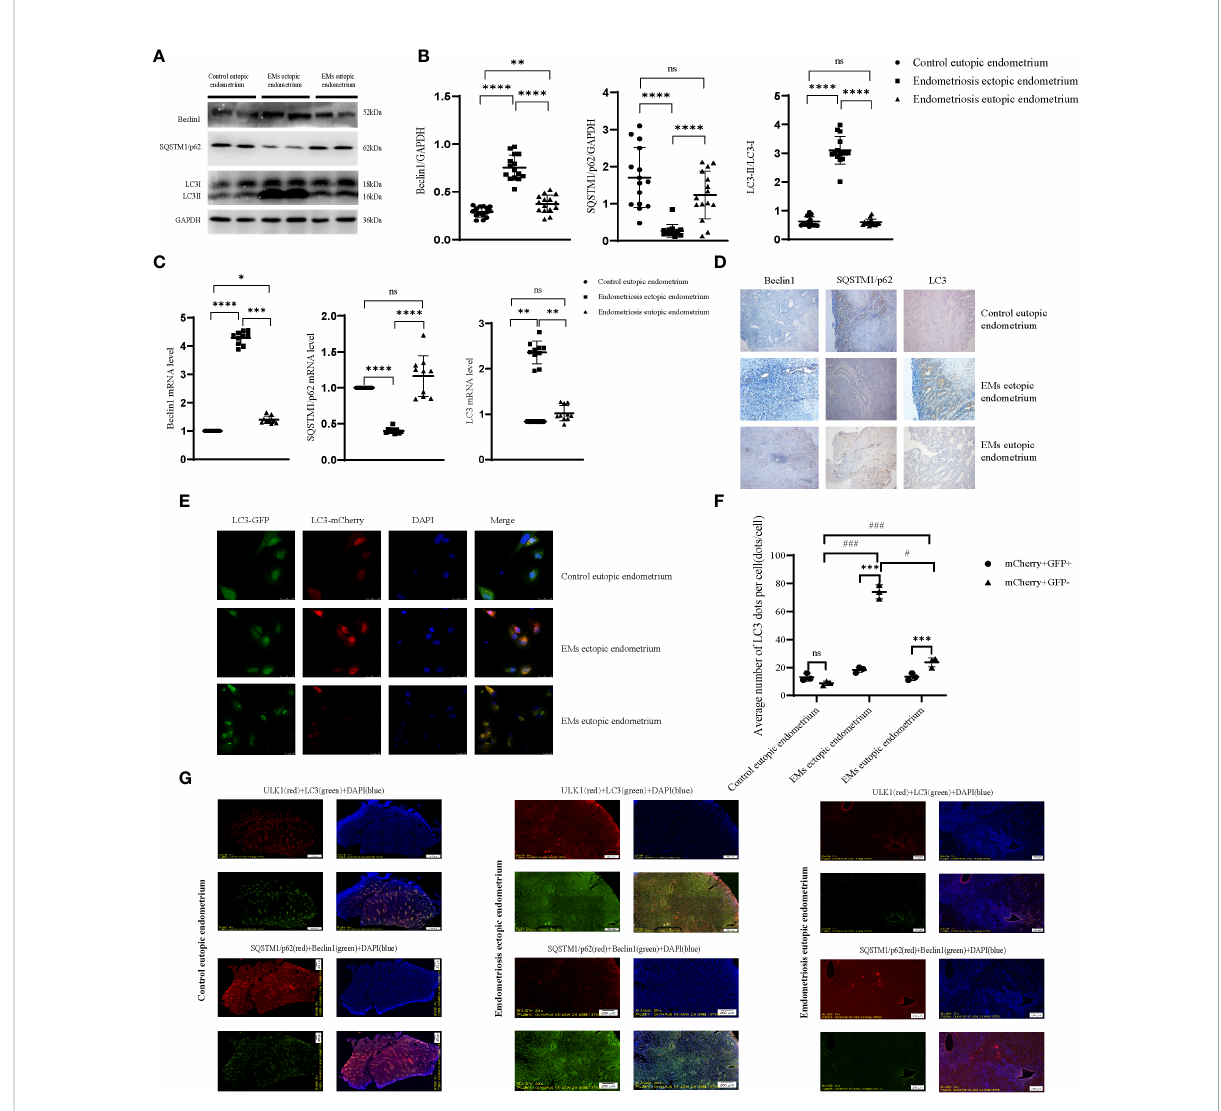
FIGURE 3 Autophagy is anomalous in endometriosis ectopic endometrium. (A, B) The protein level of autophagic genes by western blot; representative examples of Beclin1 , SQSTM1/p62 , and LC3B . (C) The mRNA level of autophagic genes. (D) Representative examples of immunohistochemistry staining of Beclin1 , SQSTM1/p62 , and LC3B in the endometrial tissues of endometriosis eutopic and ectopic endometrium (vs control eutopic endometrium). (E, F) The human primary endometrial cells were transduced with mCherry-GFP- LC3 adenovirus to evaluate the autophagy fl ux; the yellow dots indicate autophagosomes, while the red dots indicate autolysosomes. At least 5 – 10 cells per condition were imaged by a confocal microscope. (G) Representative image of the fl uorescence of panoramic paraf fi n tissue slices with the autophagic gene stain, including ectopic and eutopic endometrium of endometriosis (vs control eutopic endometrium); each tissue wax block was continuously sliced, choosing two adjacent slices that have been labelled with autophagy-associated proteins ( Beclin1 , LC3 , SQSTM1/p62 , ULK1 ). *P < 0.05, **P < 0.01, ***P < 0.001, ****P < 0.0001, # P < 0.05, ### P < 0.001, ns means not statistically signi fi cant. Values represent the mean ± standard